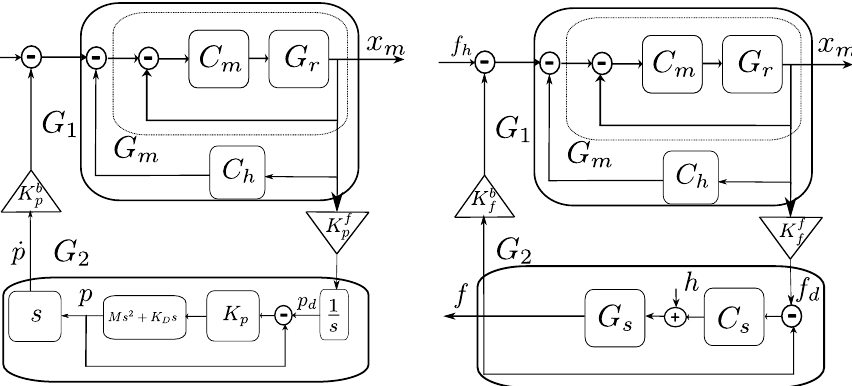
Figure 6. Block diagram of teleoperation system using the aerial manipulator in free flight ( left ) and in contact interaction ( right